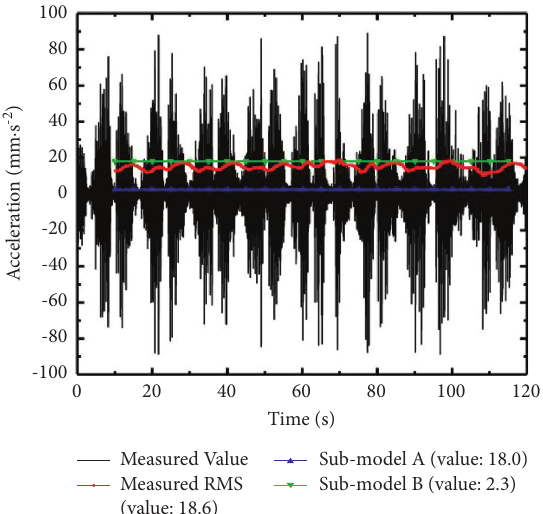
Figure 14: The time-history curve of condition and the RMS of the equivalent local model